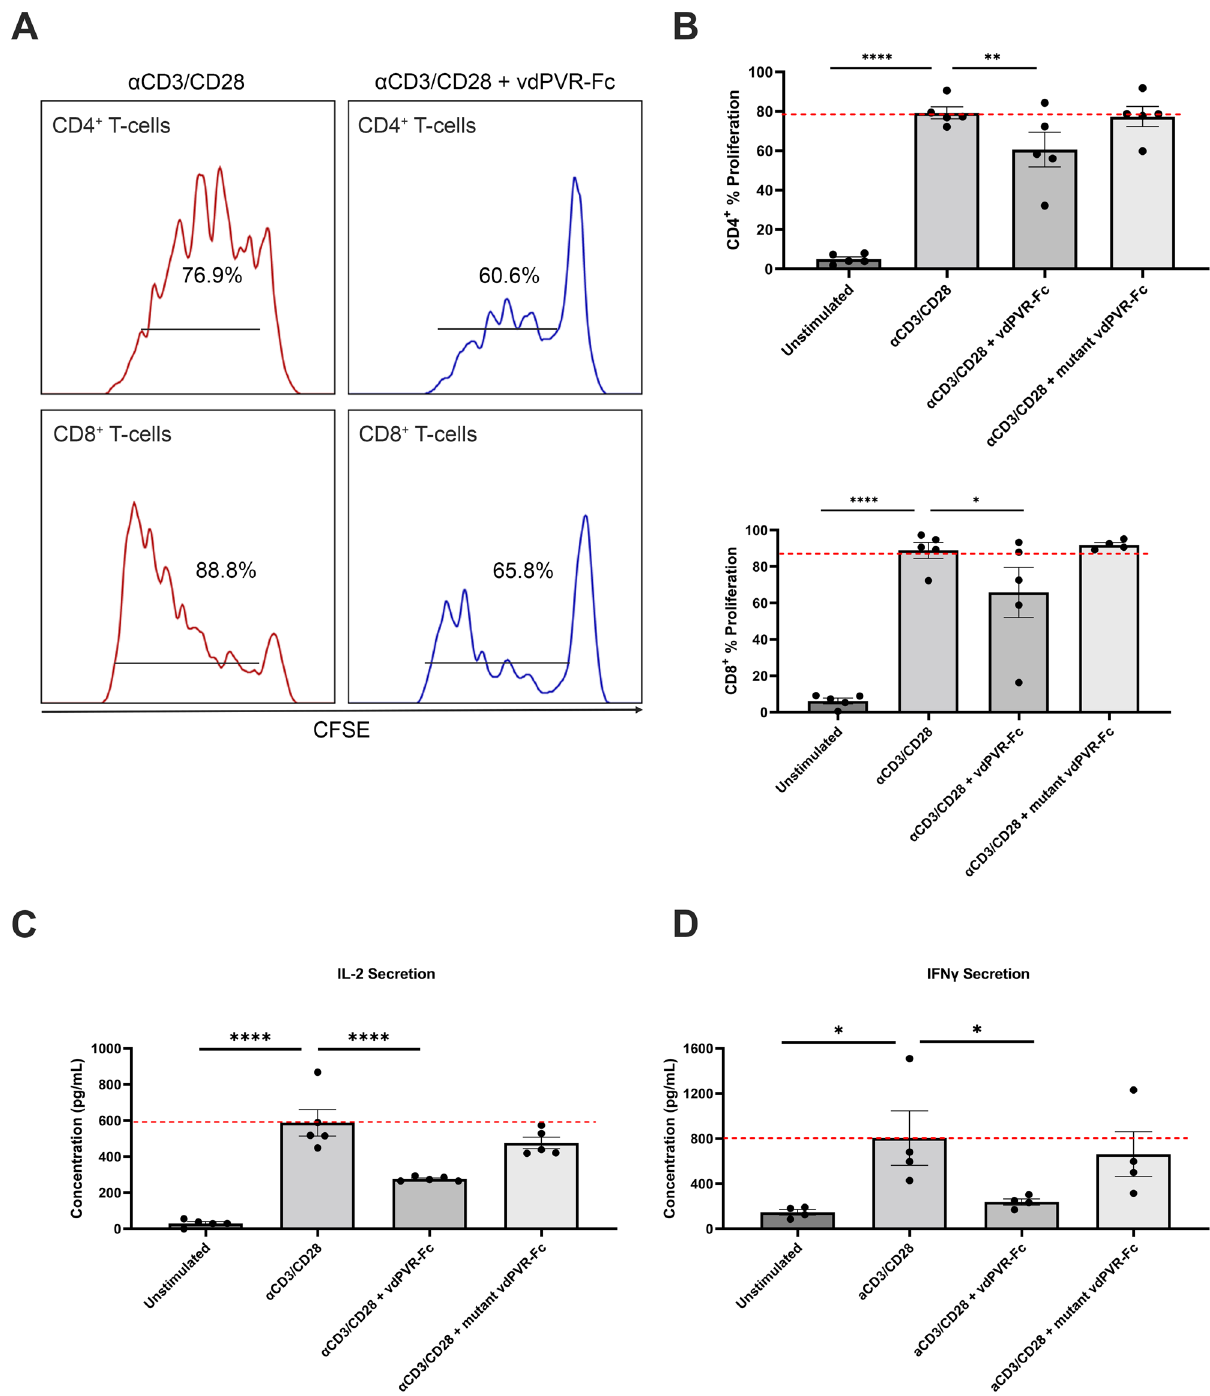
Figure 4. vdPVR-Fc as a ligand suppresses T-cell activity in mouse splenocyte cultures in-vitro. (A) Representative CFSE profiles showing the proliferation percentages of murine T-cells in splenocyte cultures stimulated with anti-CD3/CD28 beads in the presence or absence of vdPVR-Fc (10 µg/mL) for 3 days. (B) Graph showing the mean proliferation percentages of CD4 + and CD8 + T-cells unstimulated, stimulated with anti-CD3/CD28 coated beads, or with anti-CD3/CD28 beads in the presence of either vdPVR-Fc (10 µg/mL) or mutant vdPVR-Fc (10 µg/mL) after 3 days of culture. Proliferation was measured by flow cytometry as a measure of the percentage of CFSE signal associated with cell divisions over 3 days. The culture supernatants were harvested from the murine splenocyte culture after 3 days and the level of (C) IL-2 and (D) IFNγ were quantified by ELISA. Red line represents maximum stimulation using anti-CD3/CD28 coated beads. Each point on the graph represents a biological replicate. Error bars represent mean ± SEM, *p < 0.05, **p < 0.01 and ****p < 0.0001 evaluated by one-way ANOVA relative to anti-CD3/CD28 coated beads